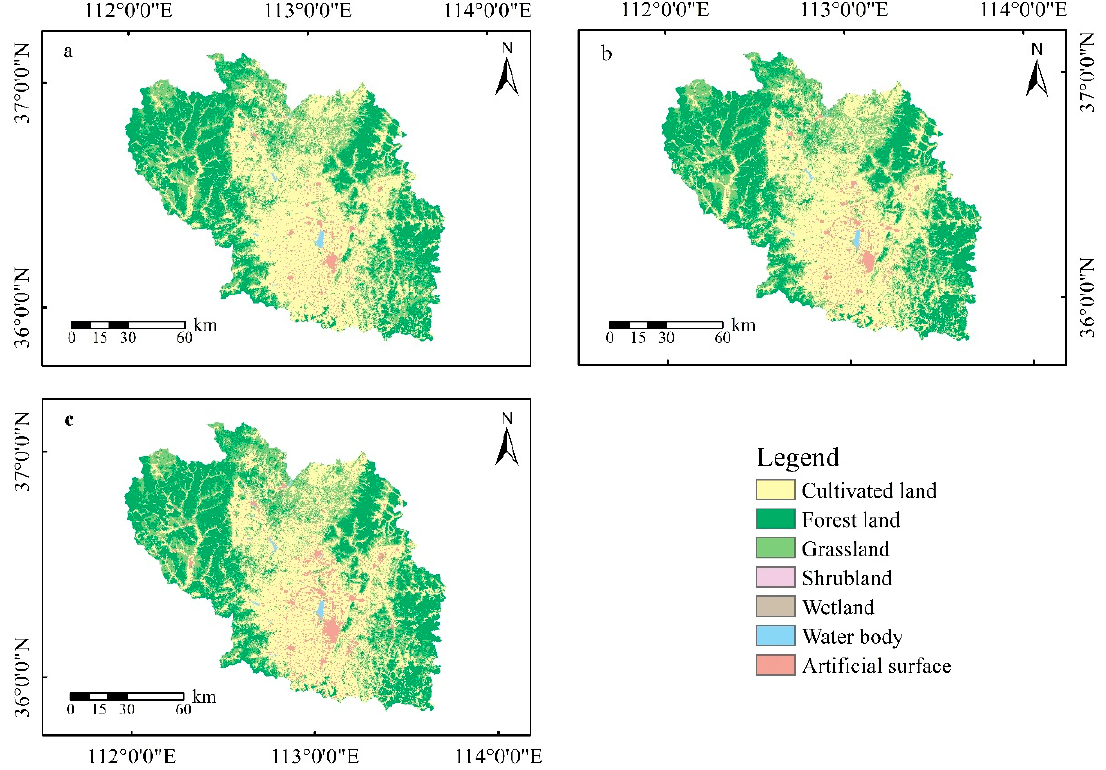
Figure 3. Land use and land cover (LULC) in 2000 ( a ), 2010 ( b ), 2020 ( c ) in Changzhi City.